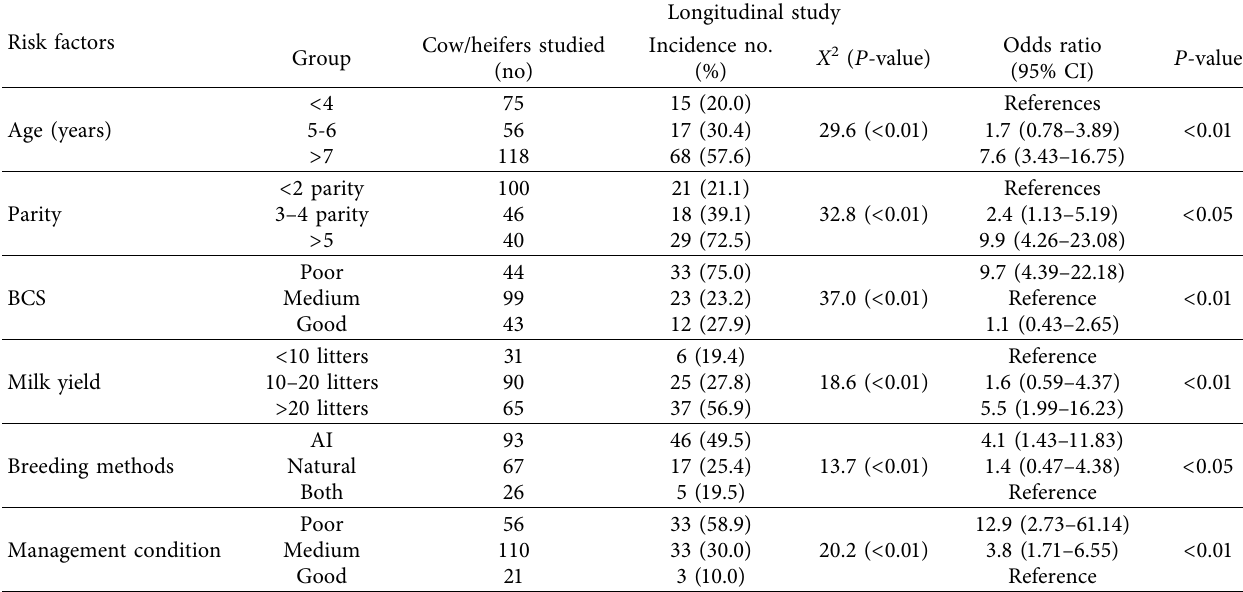
Table 4: Incidence of repeat breeding with risk factors (age, parity, BCS, milk yield, breeding methods, hygiene, and feeding management in crossbred cow/heifers.